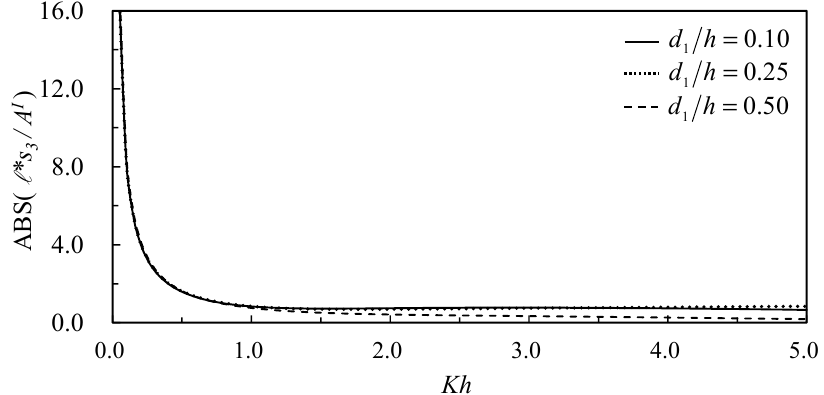
Figure 16. Heave amplitude versus relative water depth for various submerged depths of the structure ( d 1 / h = 0.10, 0.25, and 0.50).